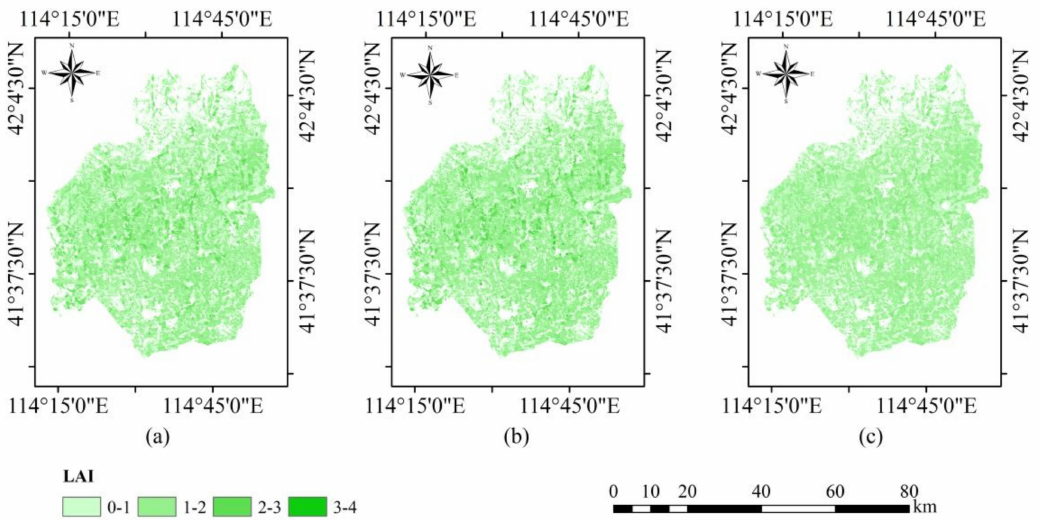
Figure 5. Spatial distributions of LAI predictions in Kangbao County obtained by three models: ( a ) traditional kNN; ( b ) RF; and ( c ) modified